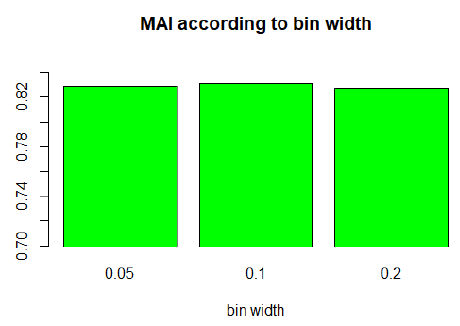
Figure 9. MAI of FWS according to bin width ( K = 3).